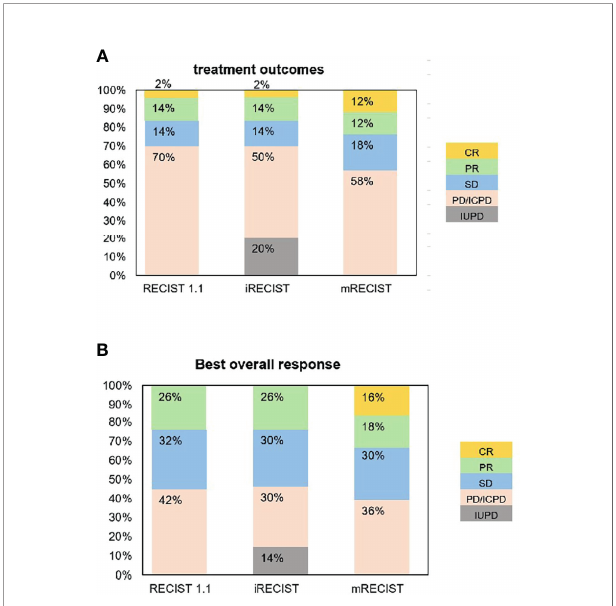
FIGURE 3 | Treatment outcomes (A) and best tumor response (B) per RECIST 1.1, iRECIST, and